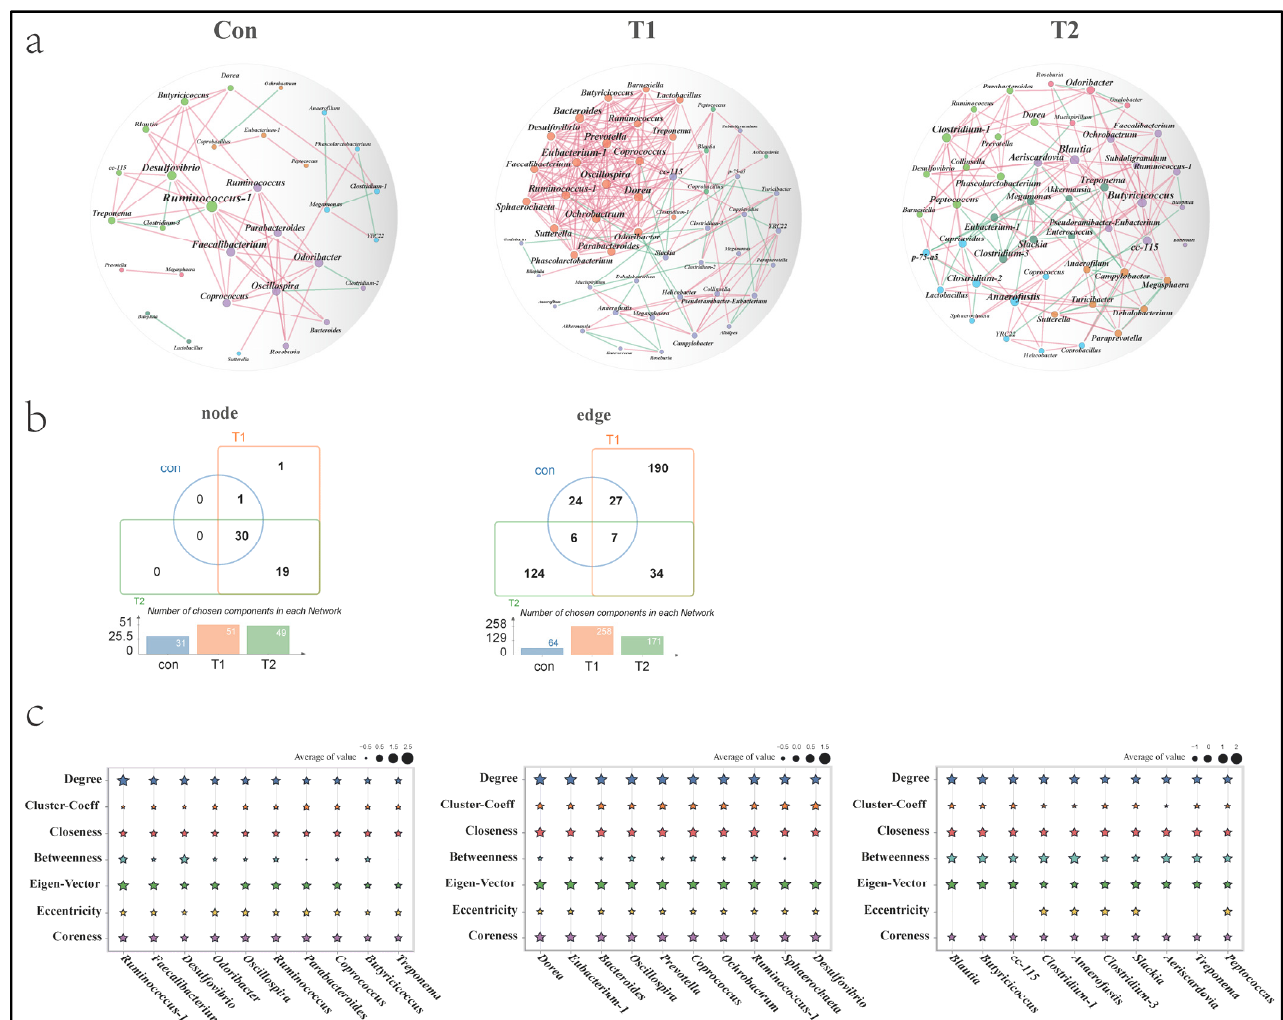
Figure 5. The co-expression correlation network analysis of the microbial community. ( a ) Each node represents a genus, and each node’s size represents the nodal degree. The node with the same color represents the same module. The red edges represent a positive correlation, and the blue edges rep- resent a negative correlation. ( b ) Venn diagrams of the nodes and edges in each netwo rk ( c ) Ac- cording to the nodal degree ranking, network topological properties were drawn across each treat- ment. Different star colors represent different network topological properties.